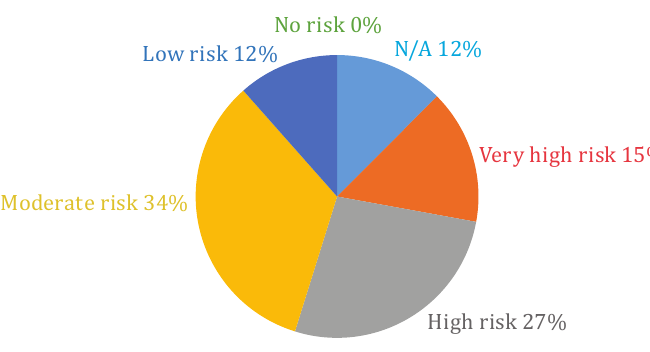
Figure 11. Rating of bridge distress (Cracks)